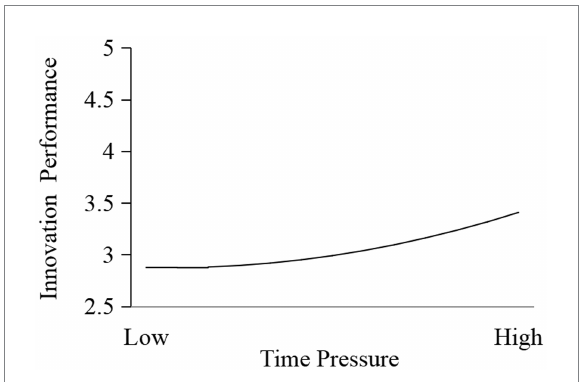
FIGURE 6 J-shaped effect of time pressure on innovation performance.